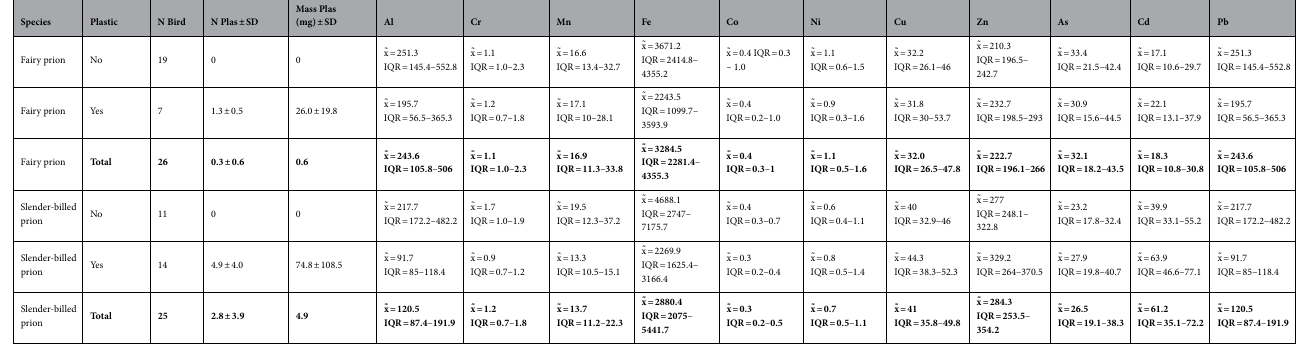
Table 1. Summary results including ingested plastic loads of the examined fairy and slender-billed prions, median (x ̃ ) and interquartile range (IQR) of metal(loid) concentration in the birds’ livers (mg/kg of dry mass). Concentration data for some metal(loid)s from one fairy prion were